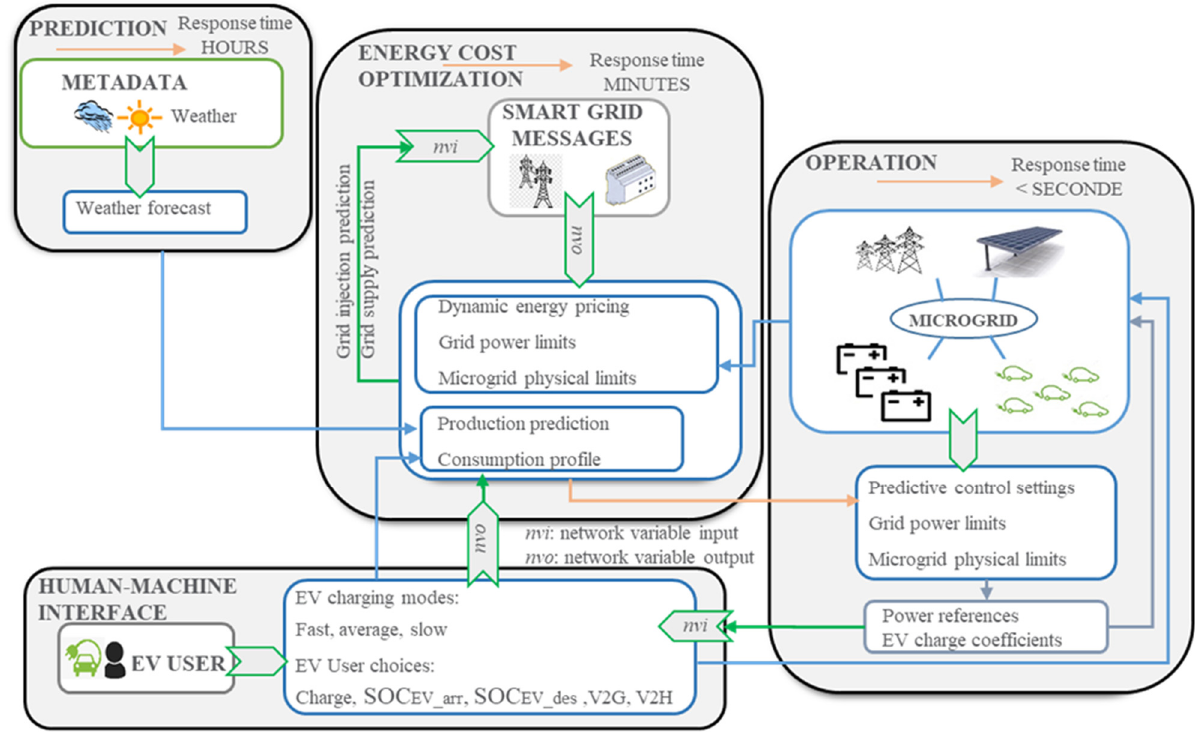
Figure 2. Supervisory control system for the IIREVs.